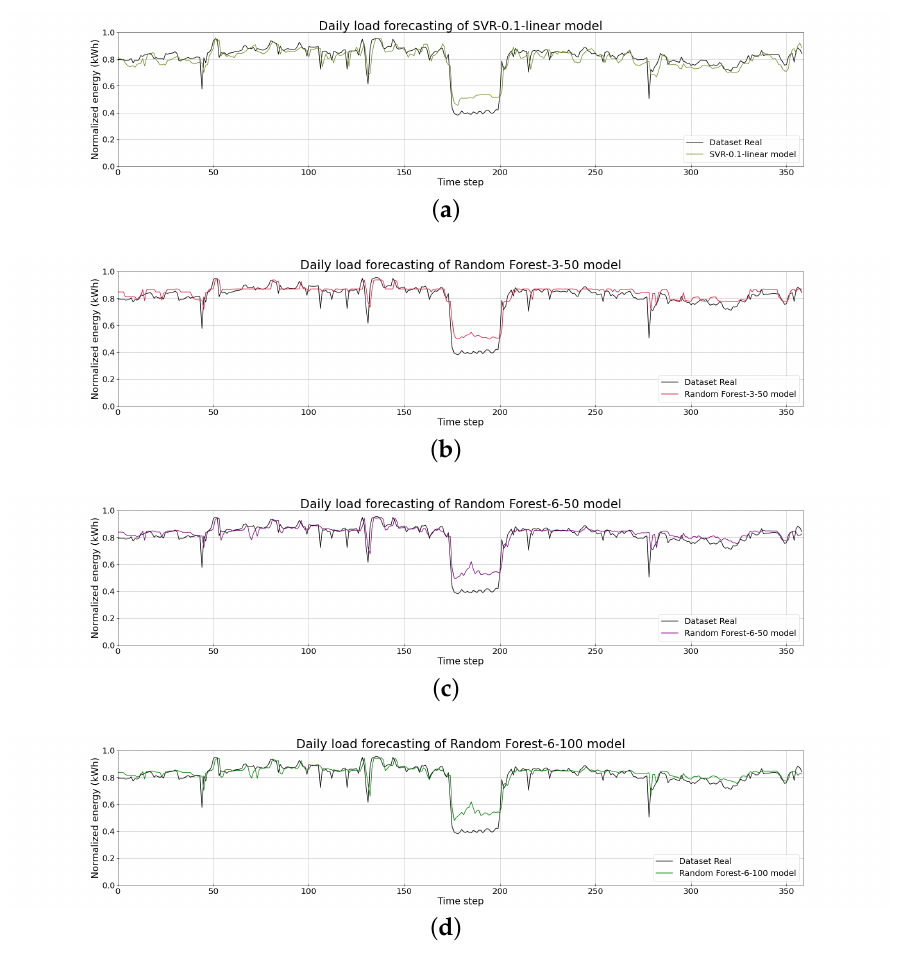
Figure 10. Daily load forecasting using ( a ) the SVR-0.1-linear model, ( b ) the Random Forest-3-50 model, ( c ) the Random Forest-6-50 model, and ( d ) the Random Forest-6-100